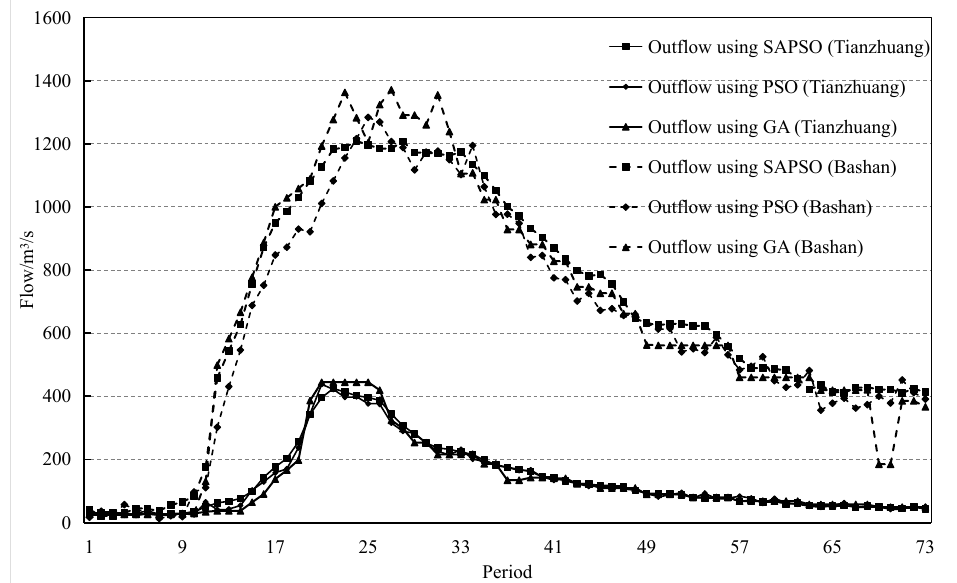
Figure 10. Outflow hydrographs for the 13 August 1974 flood using the SAPSO, PSO, and GA algo- rithms.